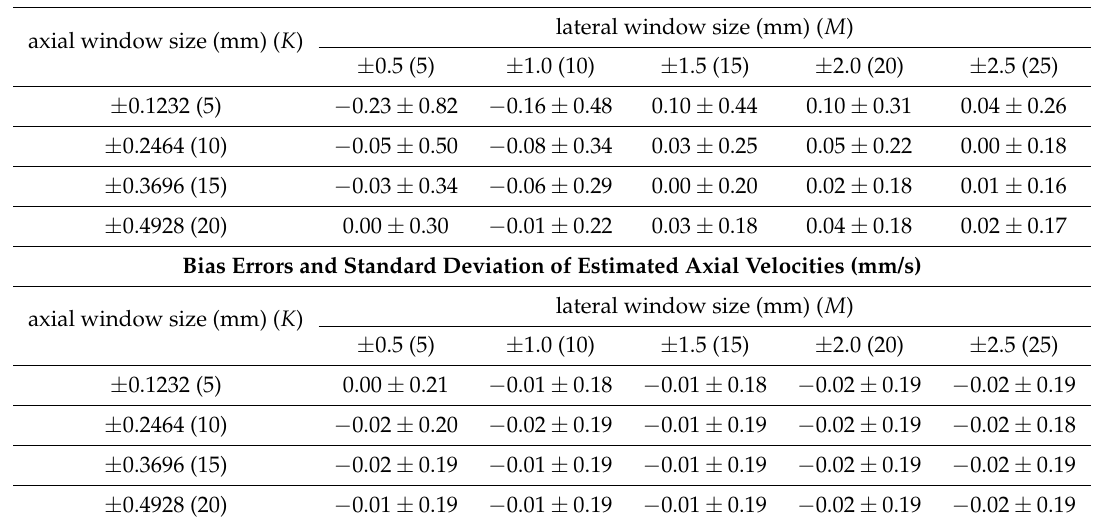
Table 3. Bias errors e bias and standard deviations σ of lateral and axial displacements at nine red points in Figure 4a estimated by the proposed paired 1D motion estimators with frame averaging. Beamformed echo signals were obtained with rectangular apodization. Actual lateral and axial velocities were 2 mm/s and –1 mm/s, respectively. Bias Errors and Standard Deviation of Estimated Lateral Velocities (mm/s) lateral window size (mm) ( M ) axial window size (mm) ( K )